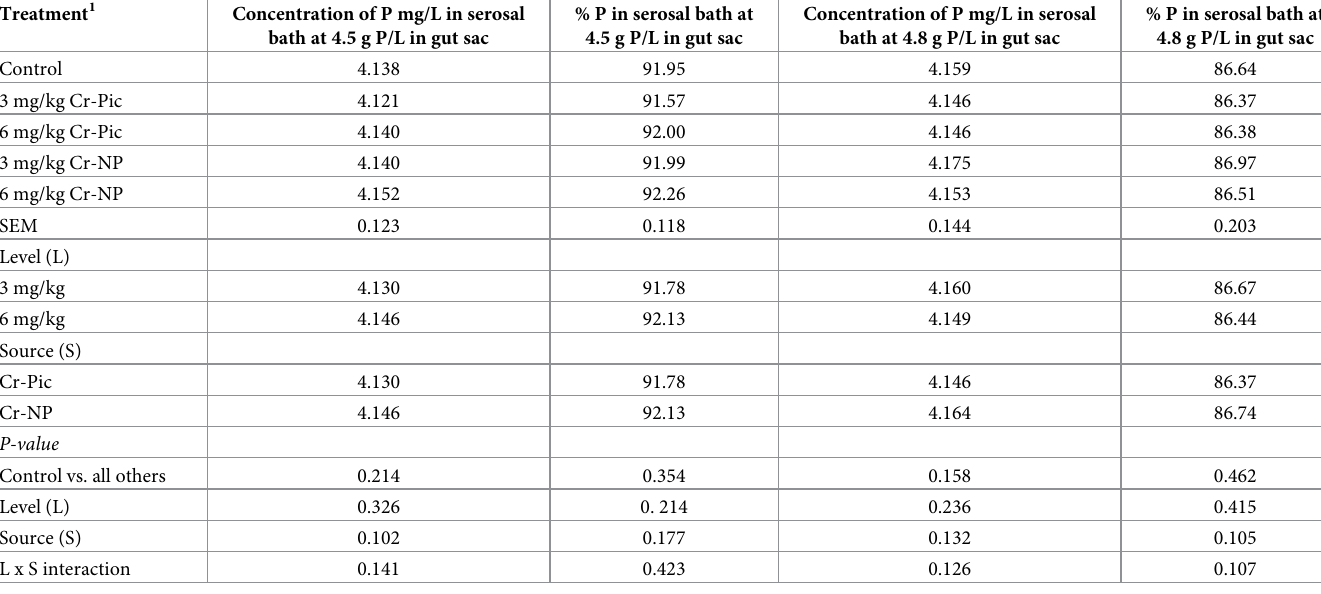
Table 3. Concentration of P in the serosal bath at 4.5 and 4.8 g P/L in the gut sac. Treatment 1 Concentration of P mg/L in serosal bath at 4.5 g P/L in gut sac